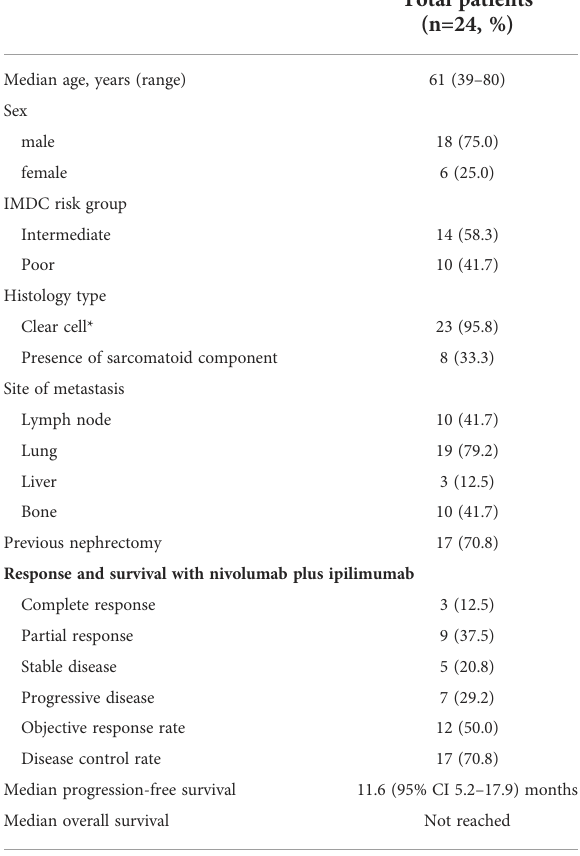
TABLE 1 Baseline characteristics of the study patients and clinical outcomes with nivolumab plus ipilimumab.